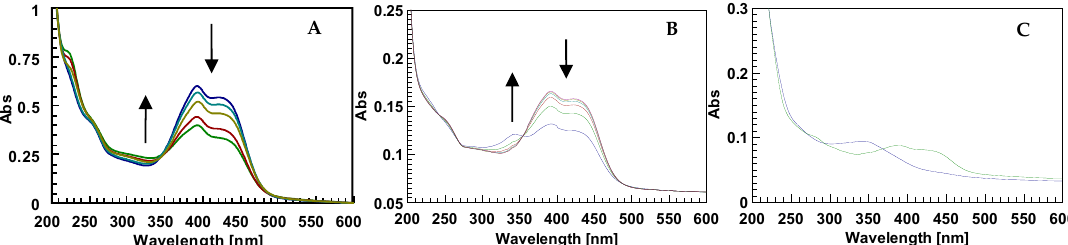
Figure 8. ( A ) Conversion of d 1RR spectrum under continuous LED irradiation at 435 nm at different exposure time (blue t = 0; light blue t = 6 h; yellow t = 12 h; red t = 15h; green t = 18 h). ( B ) Cis-to-trans conversion of d 1RR dissolved in phosphate buffered solution at pH = 8.0 after LED irradiation (12 h) at 435 nm. The arrows show the time-evolution of the UV profile in the dark, after LED irradiation. The spectra were acquired in the dark, (red line) immediately upon irradiation (blue line) and at consecutive 2-min intervals. ( C ) UV spectra of sample 1 (blue line) and of sample 2 (green line).